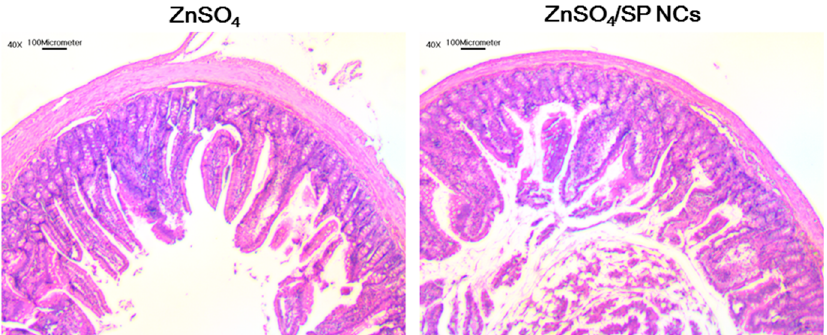
Figure 7. H&E staining results of ZnSO 4 and ZnSO4/SP NC-treated groups. The length of the scale bar in the image is 100 μ m.